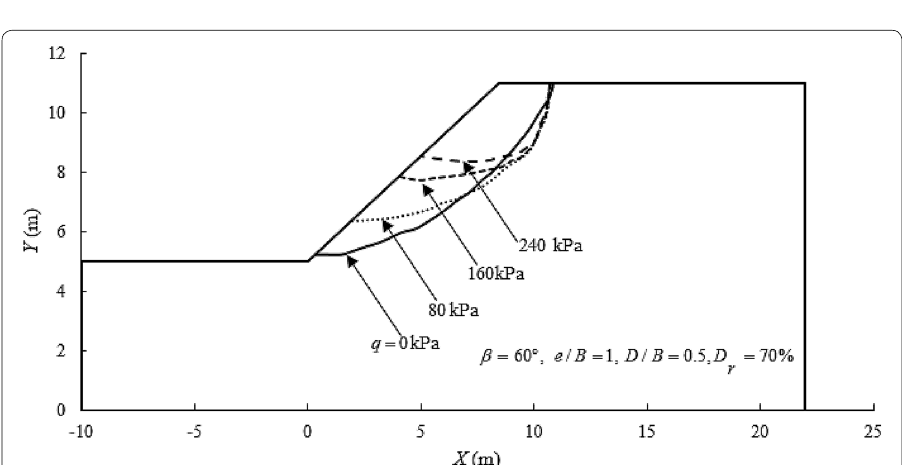
Fig. 13 Slip surface pattern with applied pressure,